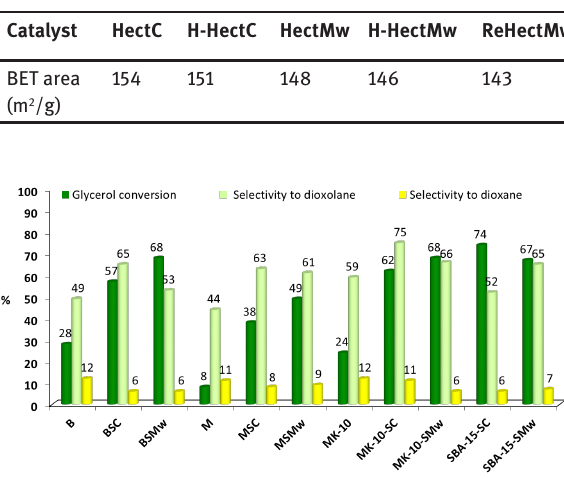
Table 2: BET surface area of the hectorite catalysts.